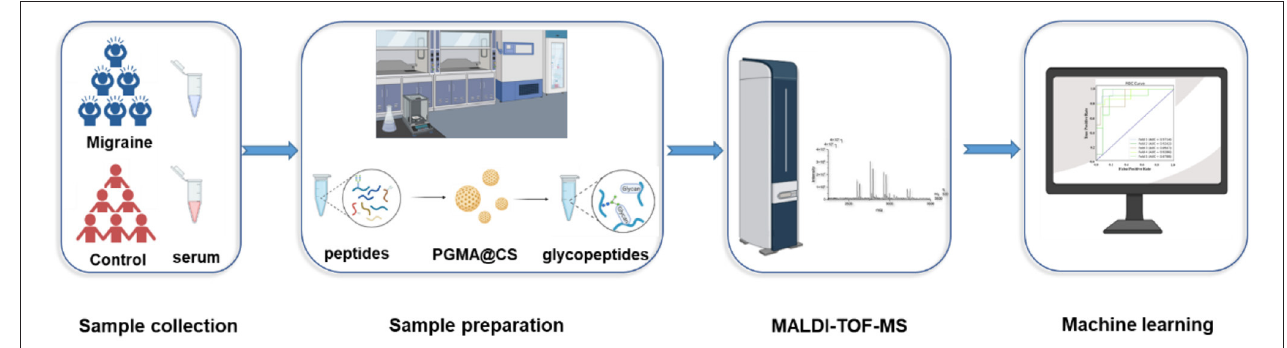
FIGURE 2 | The high-throughput and effective strategies for obtaining and analyzing IgG intact N-glycopeptides for patients with migraine and healthy control subjects.